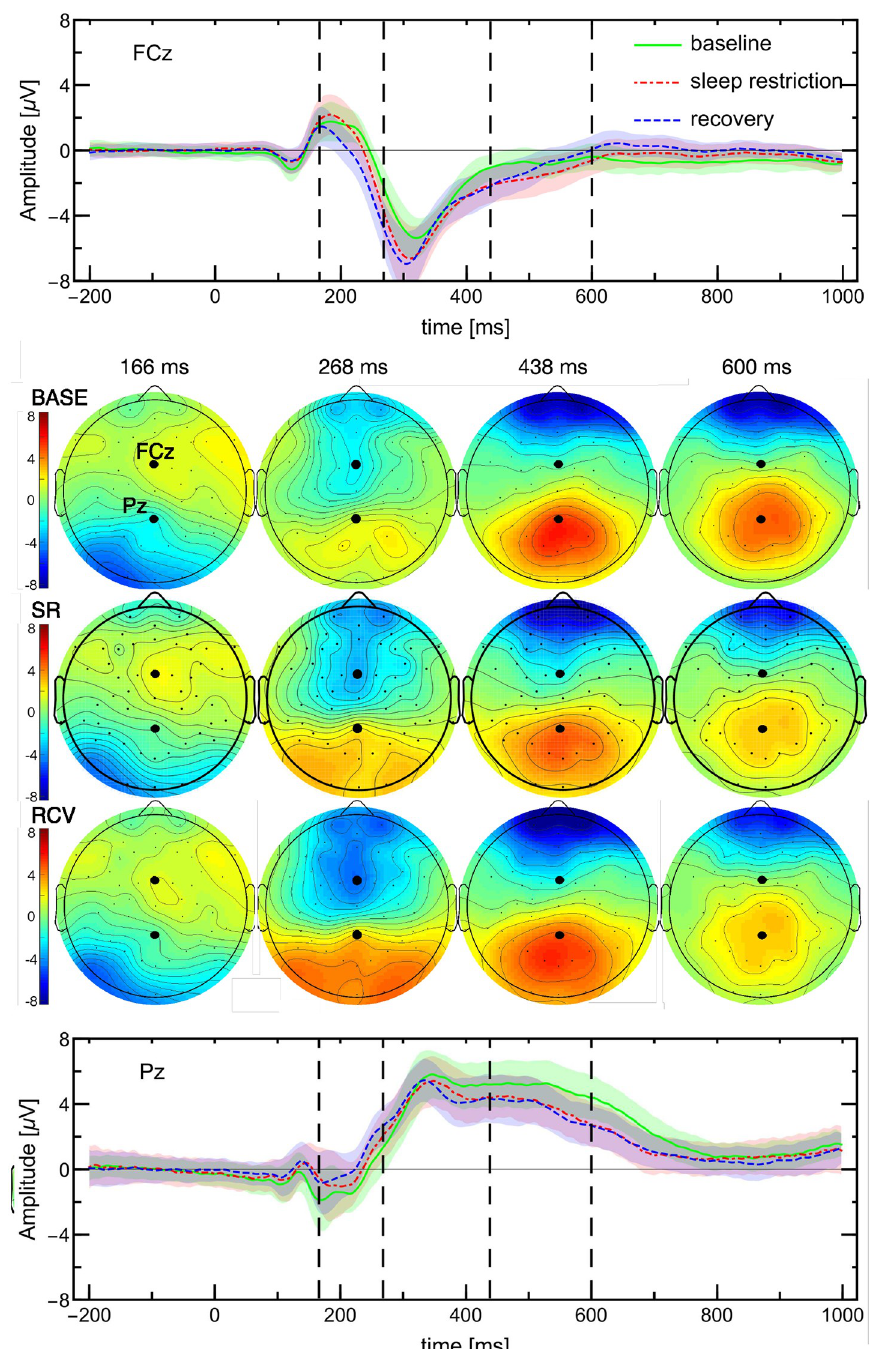
Fig 4. Activation maps and ERPs in response to Stroop task (average of congruent and incongruent stimuli) with 200 ms baseline. The ERPs of BASE, SR (days 10–14), and RCV are shown at the two locations (FCz and Pz) that correspond to the largest differences between these conditions, cf Fig 5. Four time points (dashed vertical lines at 166, 268, 438 and 600 ms) are chosen on the same basis. The shaded areas are standard errors (mean SE ’ 1.1 μV ). The maps are shown in columns corresponding to these times points; their amplitude scale is the same as in the ERP plots. The differences visible in maps at 268 ms can be attributed to change in latency.